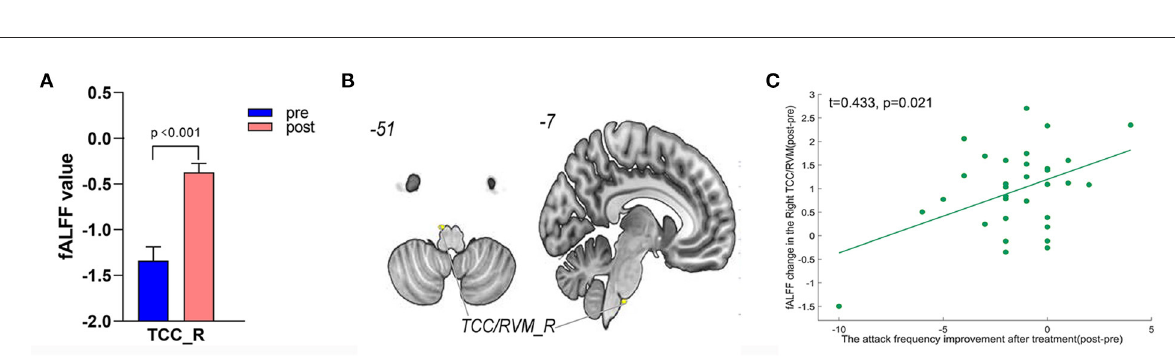
FIGURE6 Treatment response of fALFF (mean ± sem) and correlation between fALFF changes and migraine frequency changes (FDR corrected). (A) Significant increase of fALFF in right TCC/RVM after tVNS treatment. (B) Location of TCC/RVM, (C) a positive correlation between right TCC and the reduction of migraine attack frequency (r = 0.433, p = 0.021). R, right; RVM, rostral ventromedial medulla; TCC, trigeminal cervical